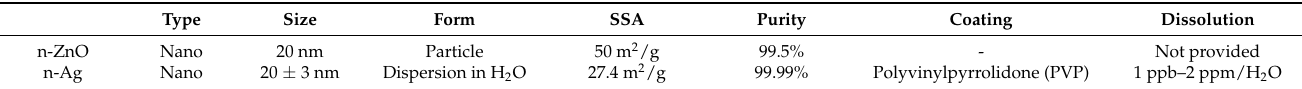
Table 1. Characteristic of nanosized ZnO and nanosized